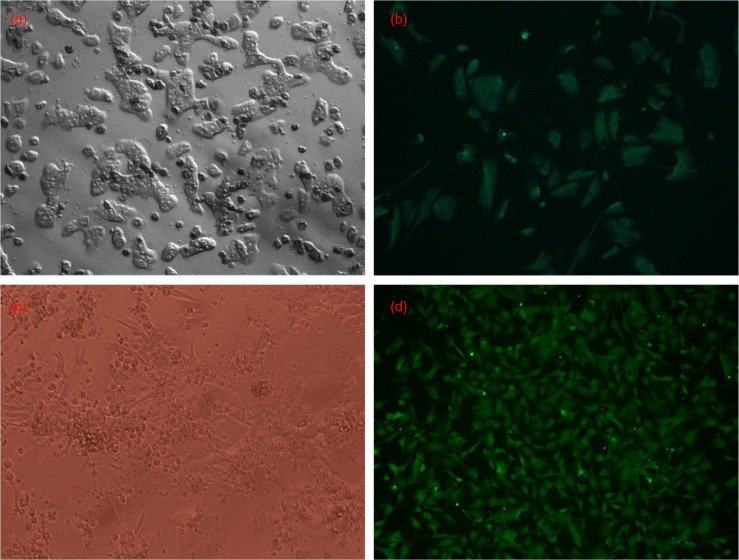
Hepatocytes and cardiomyocytes in vitro. (a) Hepatocytes in culture (200×). (b) CK-18 (green) staining of hepatocytes (200×). (c) Cardiomyocytes in culture (100×). (d) Sarcomeric actin (green) staining of cardiomyocytes (100×).